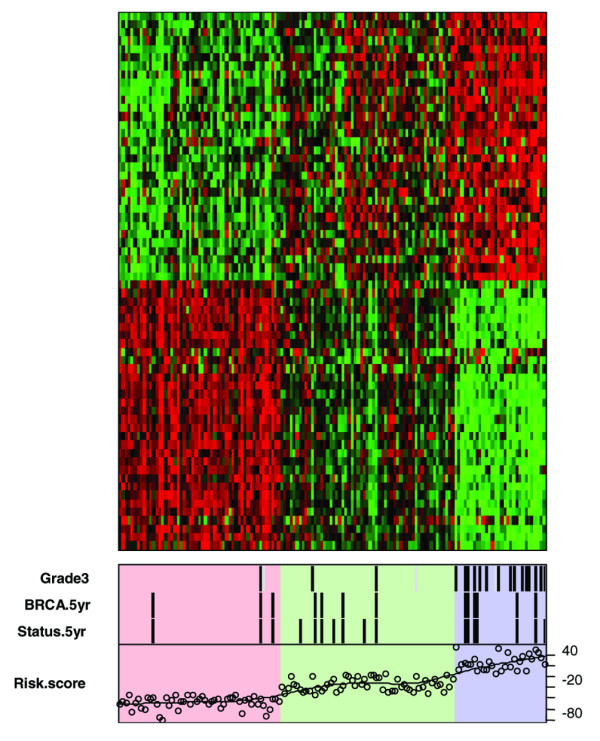
Supervised clustering of the node-negative untreated cohort in Uppsala (n = 135) using the 64-gene set. The accompanying variables have the same meaning as in Fig. 2.